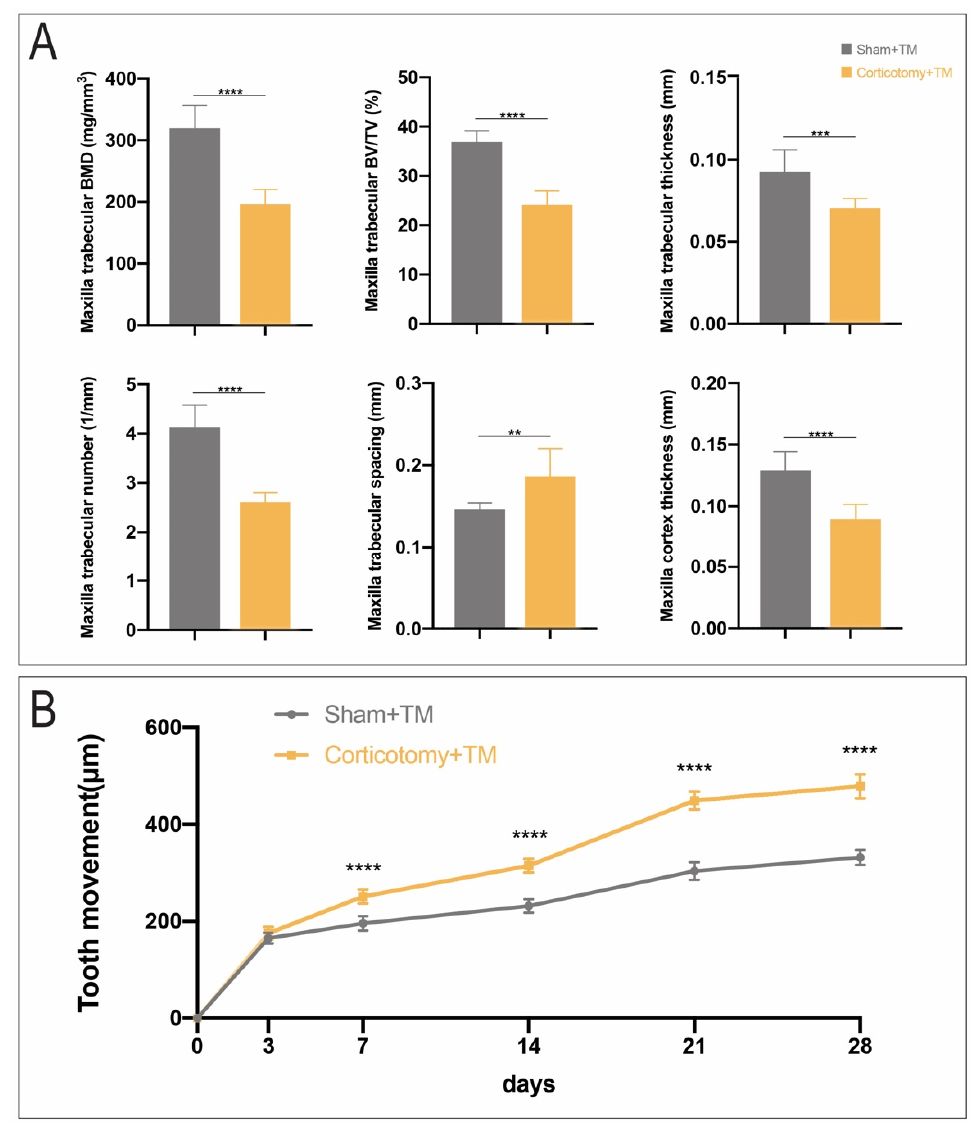
Figure 5. Comparative analyses of the micro-CT measurements. ( A ) Histomorphometric parameters of inter-radicular alveolar bone of the maxillary first molar ( n = 12). The Sham + TM group vs. the Corti + TM group. ( B ) Distance of orthodontic tooth movement of the maxillary first molar ( n = 12). The Sham+TM group vs. the Corti + TM group. Abbreviations: BMD: Bone Mineral Density; BV/TV: Bone Volumn/Tissue Volumn; *: p < 0.05; **: p < 0.01; ***: p < 0.001;****: p < 0.0001.